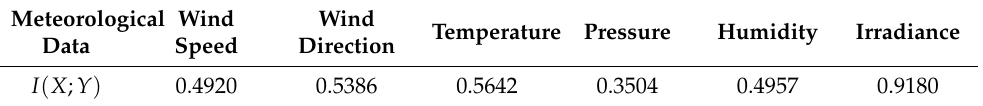
Table 1. MI values between the variables.